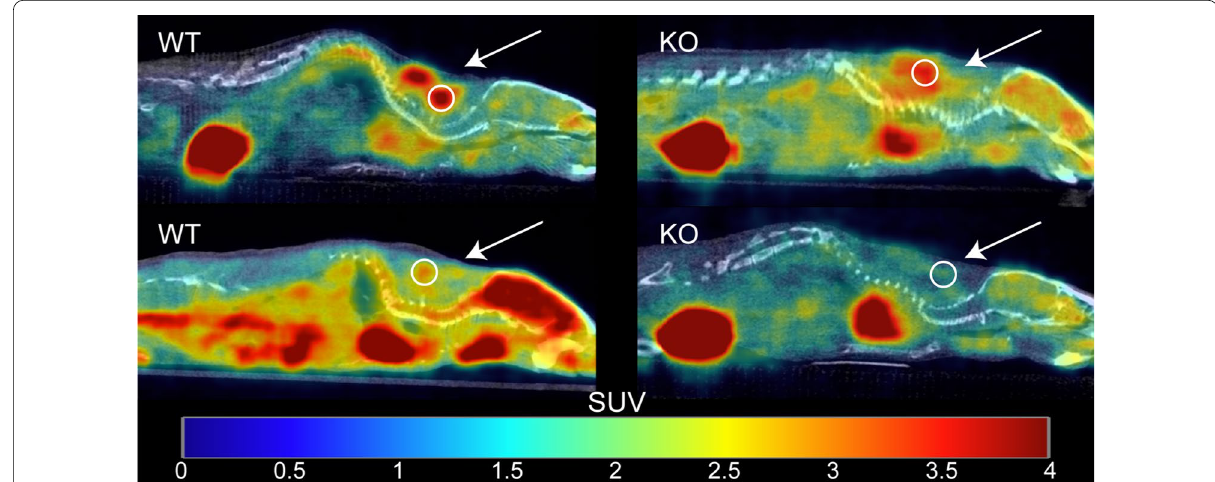
Fig. 3 Example of fused [ 18 F]FDG PET/CT images acquired from unfasted male WT and KO mice after NE injection. Images are displayed on the same SUV scale on a sagittal view. For each mouse, a 5 mm 2 ROI (circle) was drawn around the region of maximum intensity within interscapular BAT (arrow), and the corresponding SUV peak was calculated. Displayed on the left column are two different WT mice that present very different glucose uptake. Represented on the right column are two KO mice with very different [ 18 F]FDG uptake